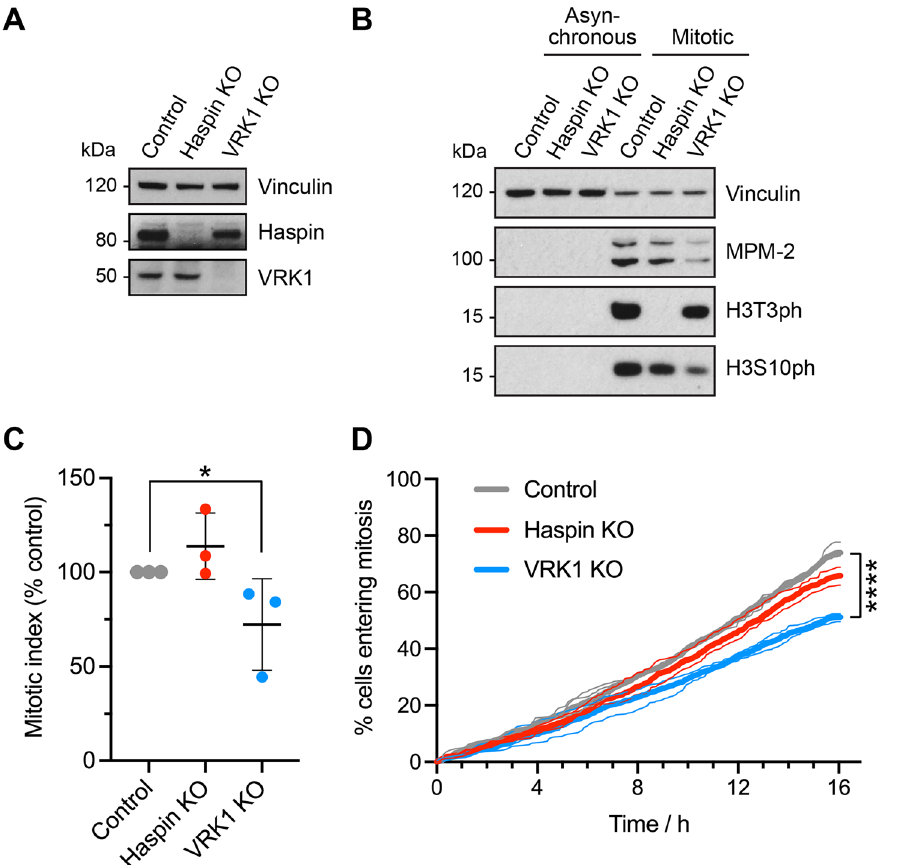
Figure 4. Histone H3 phosphorylation and cell division in control, Haspin KO and VRK1 KO HAP1 cells. ( A ) Immunoblotting shows the loss of Haspin in Haspin KO HAP1 cells, and the loss of VRK1 in HAP1 VRK1 KO cells. ( B ) Loss of VRK1 in HAP1 cells does not cause a significant loss of H3T3ph as detected by immunoblotting. The original blots are presented in Supplementary Fig. 7. ( C ) Control, Haspin KO and VRK1 KO HAP1 cells were allowed to accumulate in mitosis for 16 h in 300 nM nocodazole, and mitotic indices were then determined by immunofluorescence microscopy for MPM2. Error bars show means ± SD. *p = 0.045 (paired two-tailed Student t test using non-normalised data, n = 3). ( D ) Cumulative frequency of mitotic entry graphs for control, Haspin KO and VRK1 KO HAP1 cells observed by live imaging for 16 h. Between 193 and 555 cells were evaluated from three separate fields of view in each of three independent experiments, shown as thin lines. The combined results are shown as thick lines. Statistical significance was determined from the combined data using Kaplan–Meier curve analysis and a Mantel–Cox log rank test (****p < 0.0001). Mean cell cycle duration for Control, 24 h; Haspin KO, 26 h; and VRK1 KO, 33 h; 95% confidence intervals [23.5, 24.0], [26.0, 26.6] and [32.5, 33.0] respectively, as determined by linear